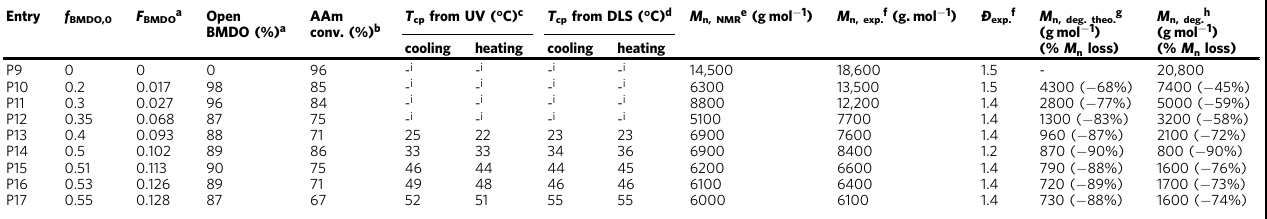
Table 2 Experimental conditions and macromolecular characteristics of P(AAm- co -BMDO) copolymers synthesized by RAFT- mediated copolymerization of AAm and BMDO in anhydrous DMSO at 70 °C for 16